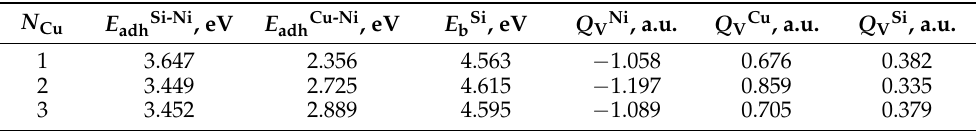
Table A2. Energy characteristics * of the systems: silicene–copper substrate (1–3 layers) with an intermediate nickel